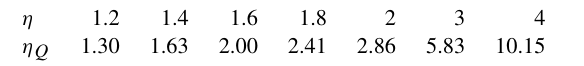
Table 1. Streamwise saltation flux ratios, η Q , for different u ∗ SD ratios, η (see text for details).